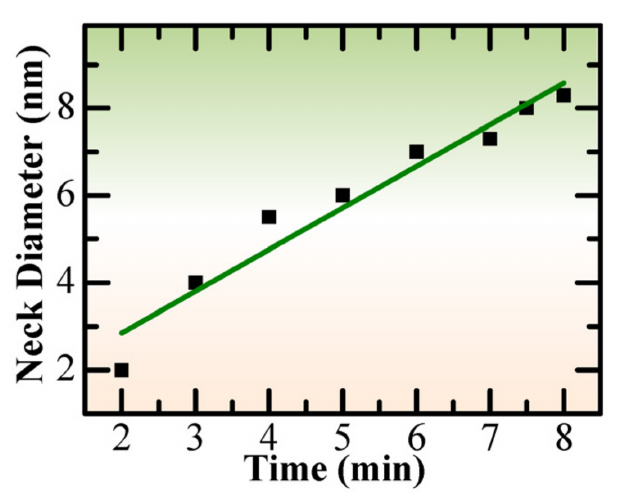
Figure 3. Statistical analysis showing the linear growth of neck diameter with time in Video S1.